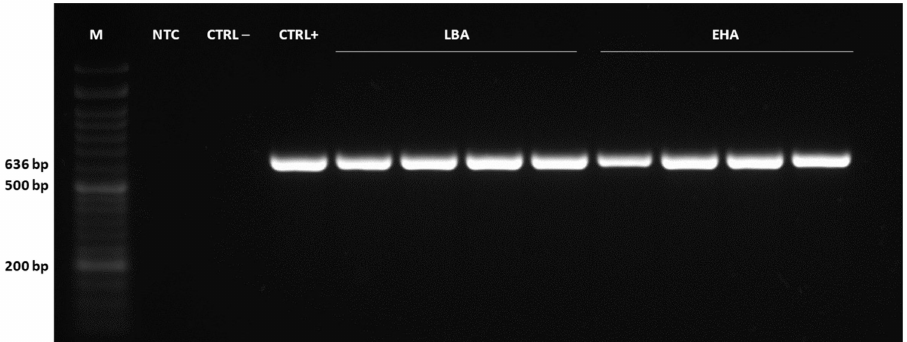
Figure 5. Confirmation of the presence of the transgene in gDNA from tamarillo embryogenic samples by PCR amplification of gus gene fragment (636 bp). M = NZYDNA Ladder VI (NZYtech, Lisboa, Portugal) ranging from 50 to 1500 bp, NTC = no template control (H 2 O), CTRL– = non-transformed sample, CTRL+ = plasmid (p35SGUSINT), lanes 5–8 = samples transformed with LBA4404 strain, lanes 9–12 = samples transformed with EHA105